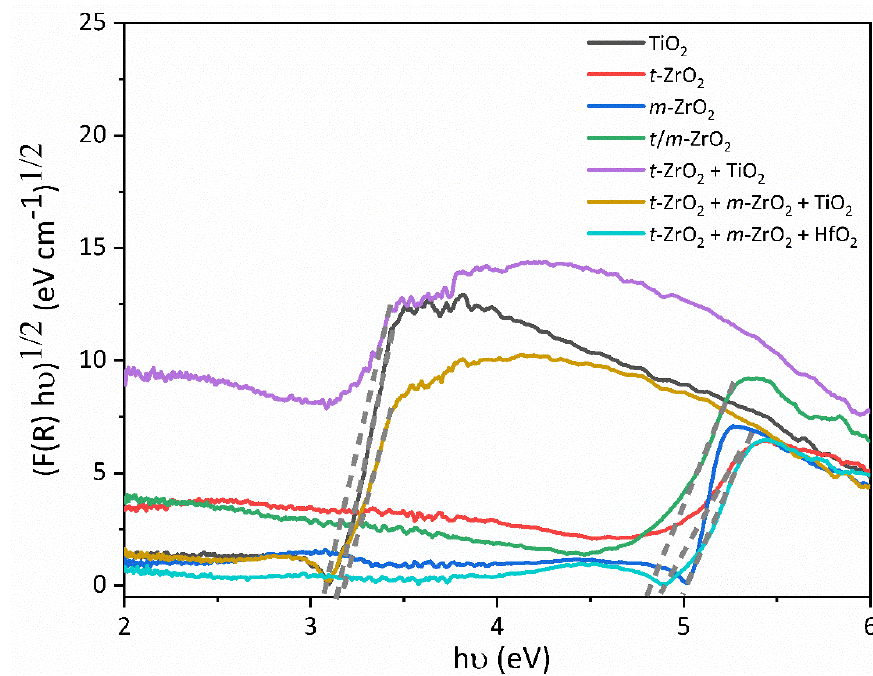
Figure 5. The plot of the Jacobian corrected Kubelka-Munk function for all